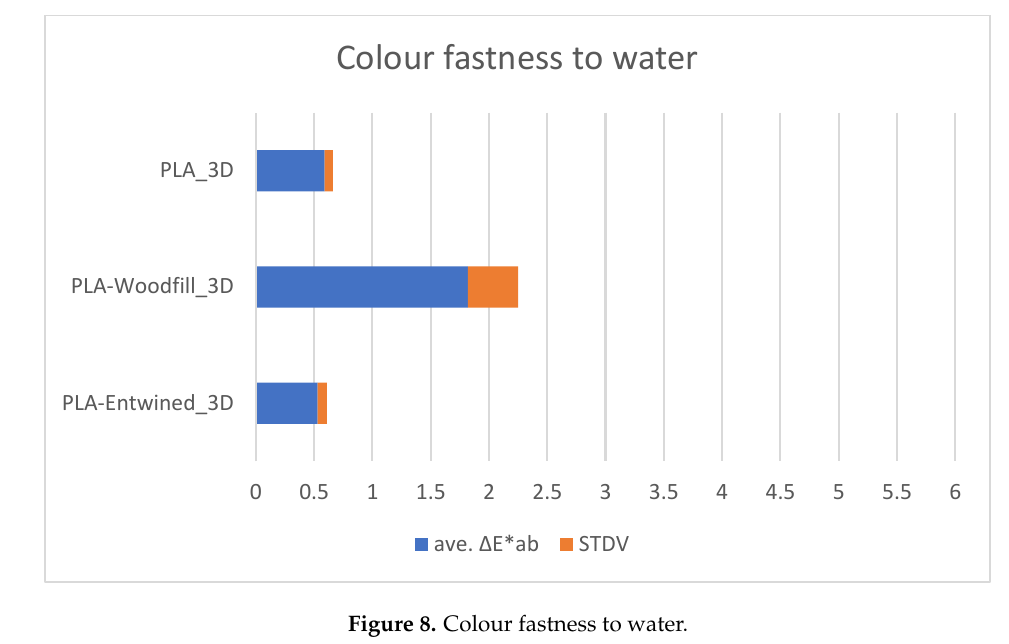
Figure 8. Colour fastness to water.